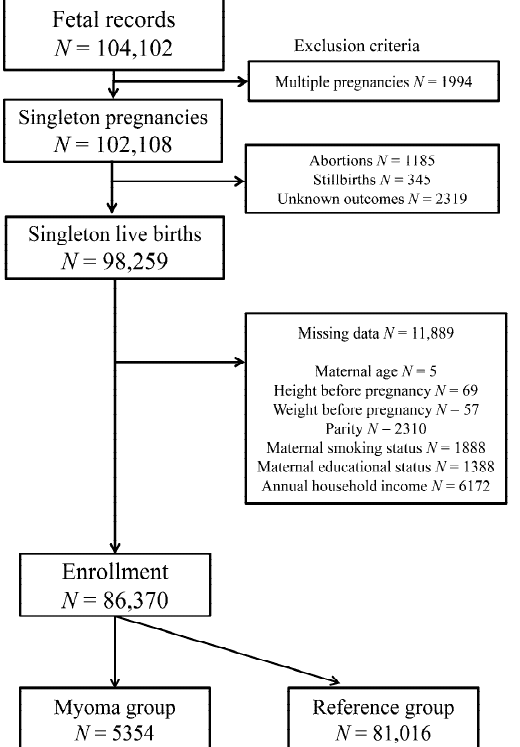
Figure 1. Flow chart depicting participant eligibility for study enrollment.